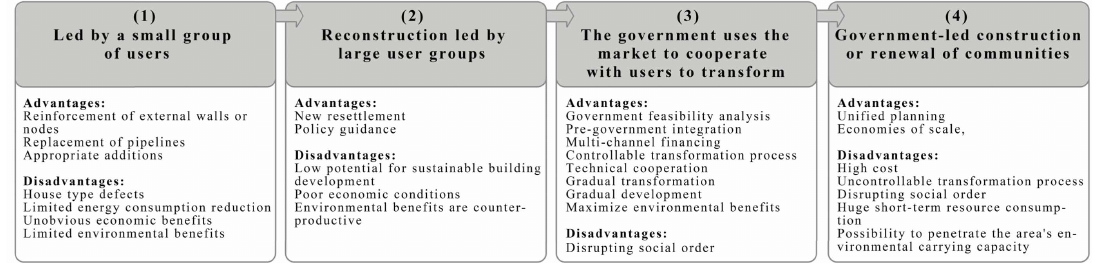
Figure 10. Comparative analysis